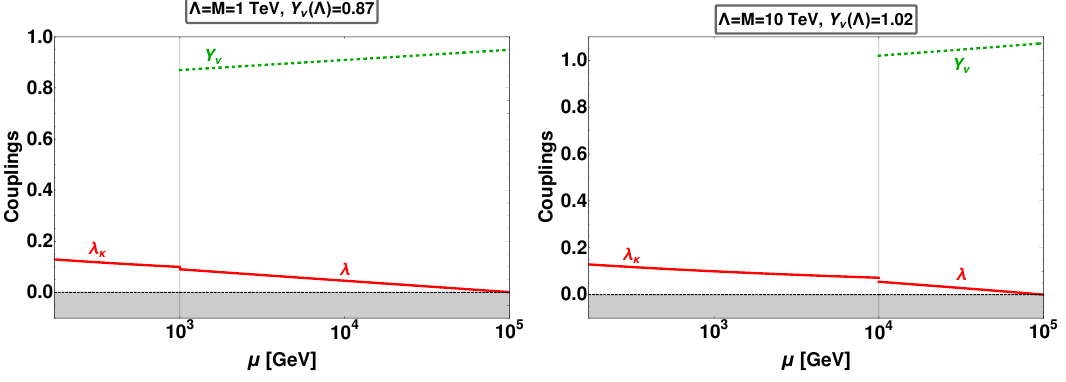
Figure 6 . Limiting Y ν by demanding Y ν to remain perturbative and λ to remain positive up to 100 TeV. Left (right) panel correspond to threshold scales Λ = 1 TeV ( Λ = 10 TeV). See text for